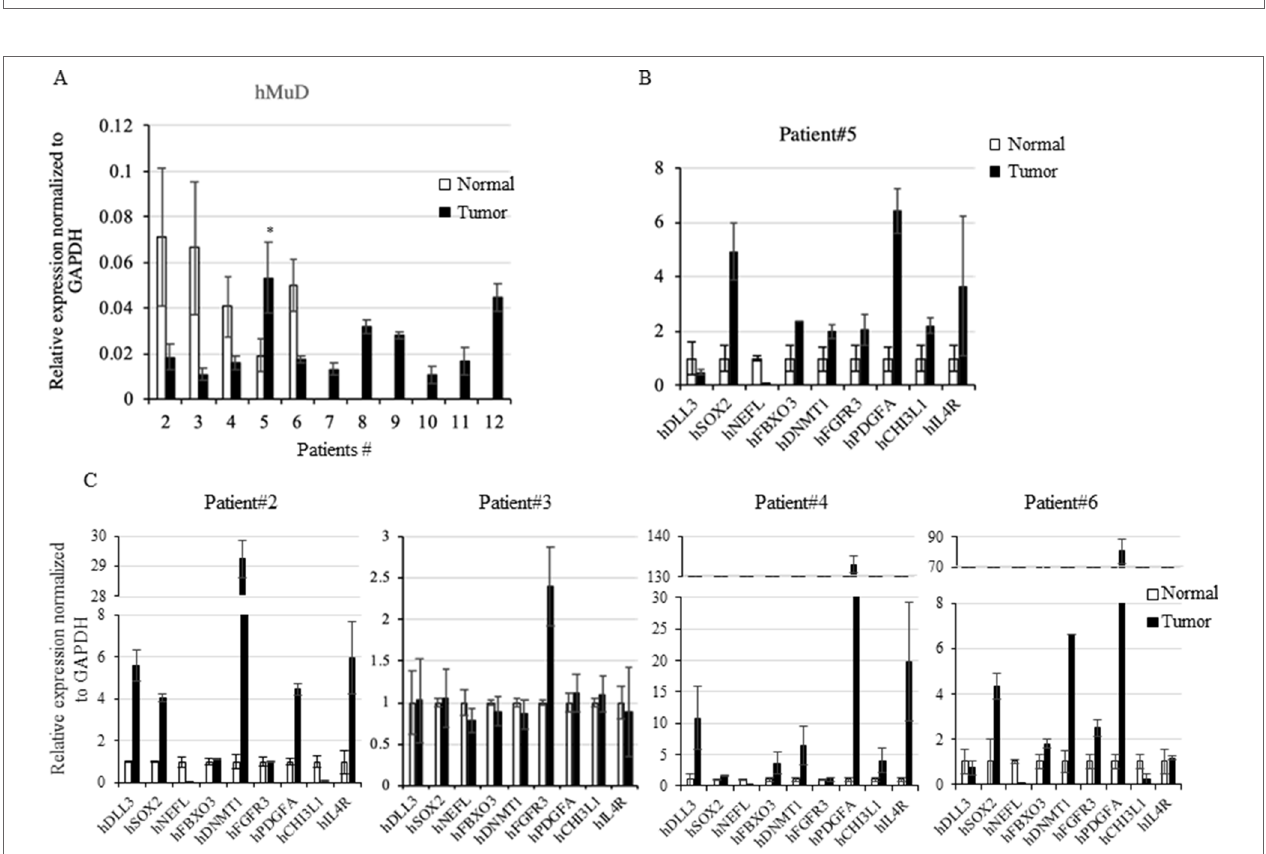
FIGURE 7 | Rt-qPCR analysis of MuD and subtypes marker genes expression. Expression of MuD mRNA analyzed with RT-qPCR in patient tissues across GBM and astrocytoma brain tumor tissues (A) . Expression of subtype markers in tissues from patient 5 (B) and other patients expression of subtype markers (C) . mRNA expression was normalized to GAPDH levels (* p <